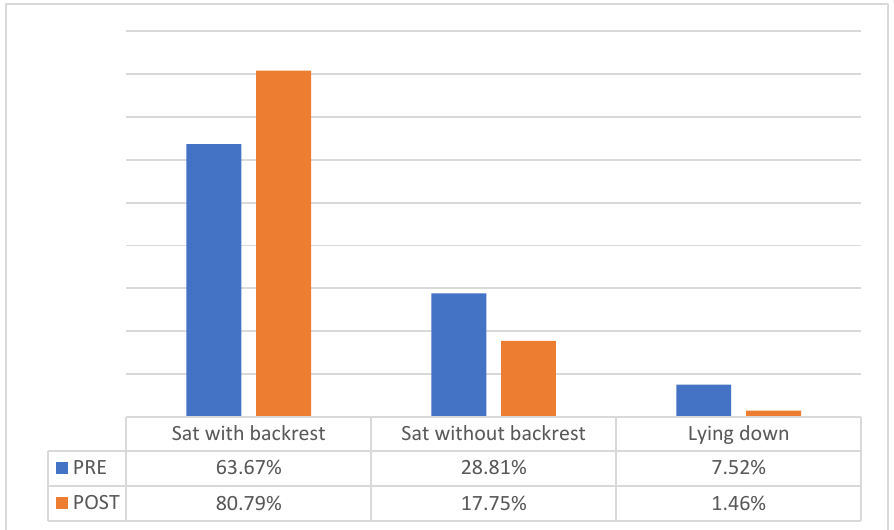
Figure 2. Column diagram of postural changes when watching television pre- and post-intervention.